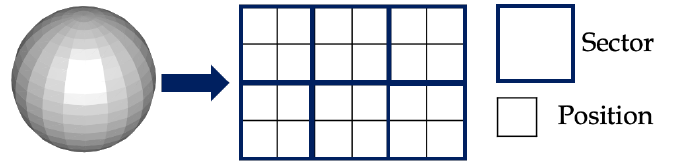
Figure 3. A schematic diagram of the ‘concept of positions’ (with 6 sectors and 24 positions; calculated using Equation (5) for the PP).